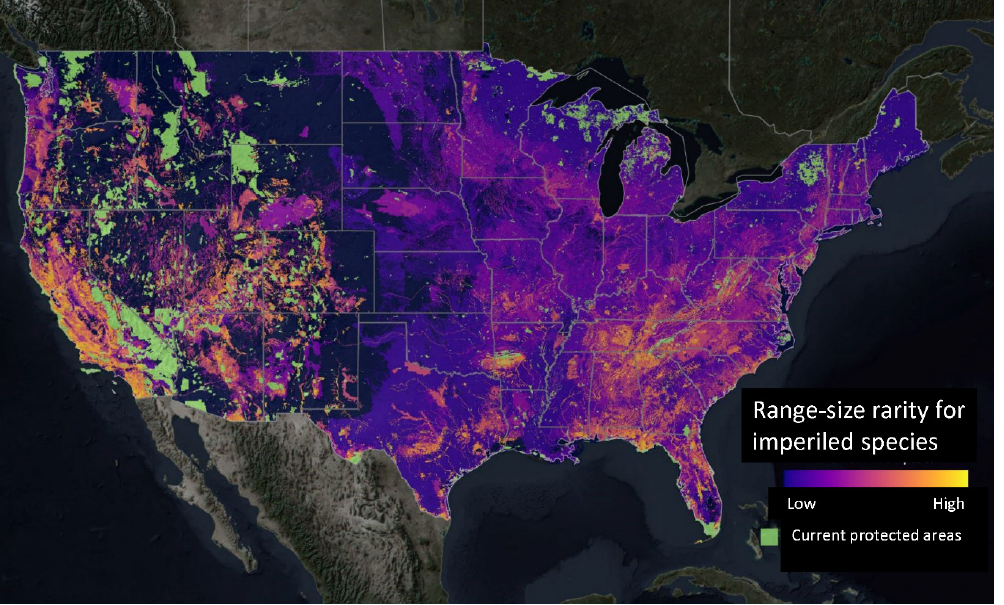
Figure 3. Summed range-size rarity of forest and non-forest species in the lower 48 states that are protected by the Endangered Species Act and/or considered to be in danger of extinction. Species include vertebrates (birds, mammals, amphibians, reptiles, freshwater fishes), freshwater invertebrates, pollinators, and vascular plants. High values (yellow) are areas where species with small ranges (and thus fewer places where they can be conserved) are likely to occur; the presence of multiple imperiled species contributes to higher scores. (Image produced by NatureServe; https: //livingatlas.arcgis.com, accessed 21 April